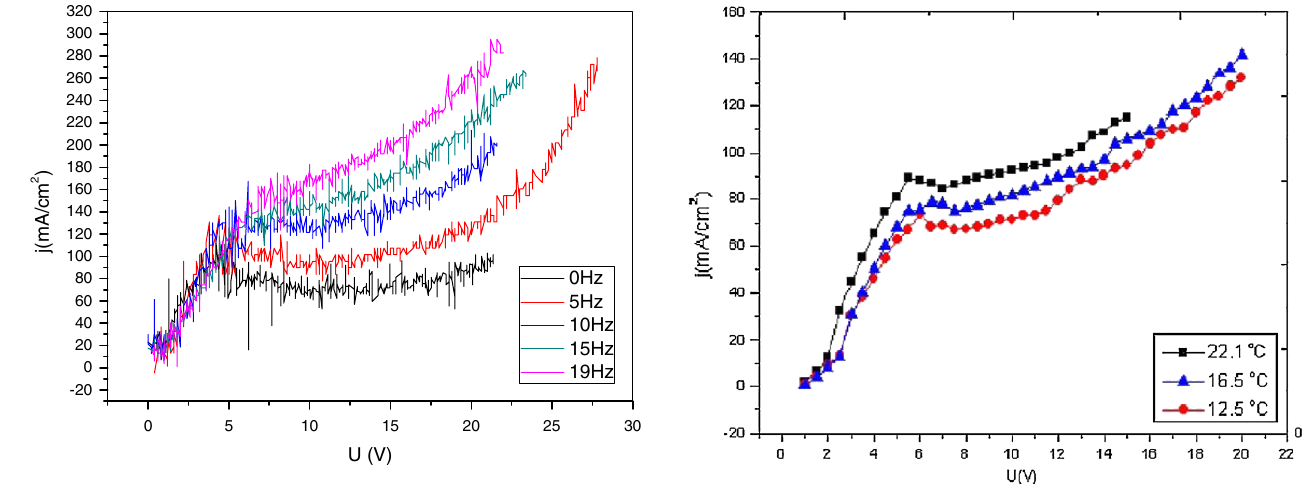
FIG. 4. (Color) Development of the I-V curve with different temperature with the stirring frequency of 11 Hz.